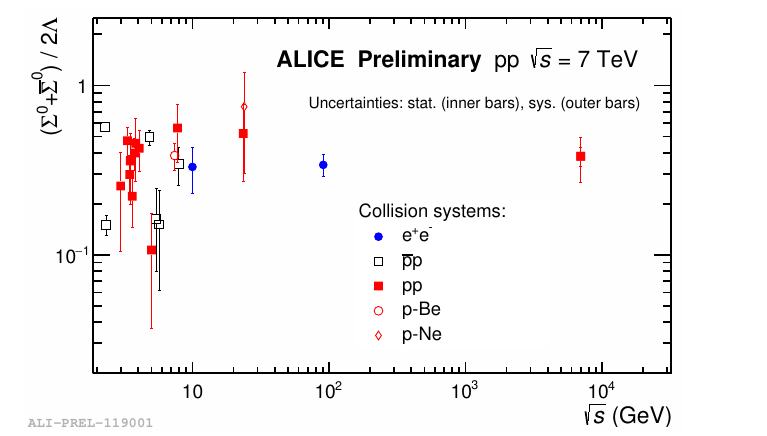
0 to 2 Λ . Non-ALICE points are